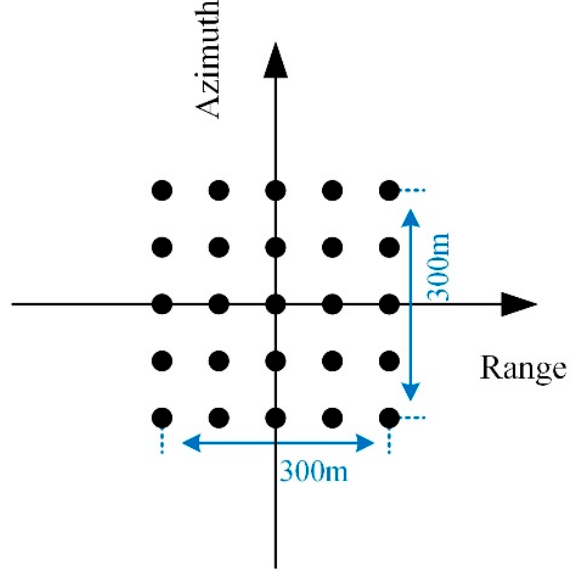
Figure 9. Illustration of the observed scene including 25-point targets.